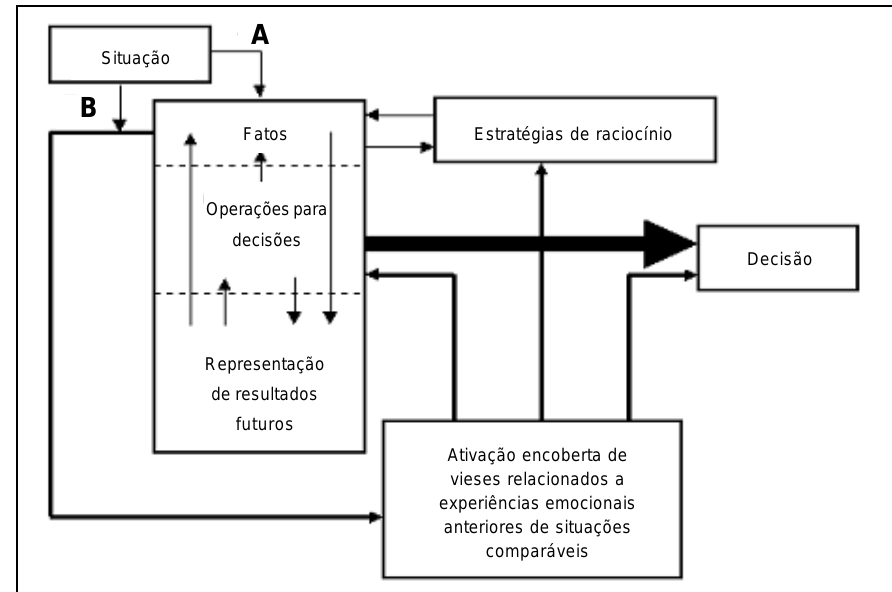
Figura 1. Esquema do modelo do Processo de Tomada de Decisão, com base na Hipótese do Marcador Somático (Bechara,